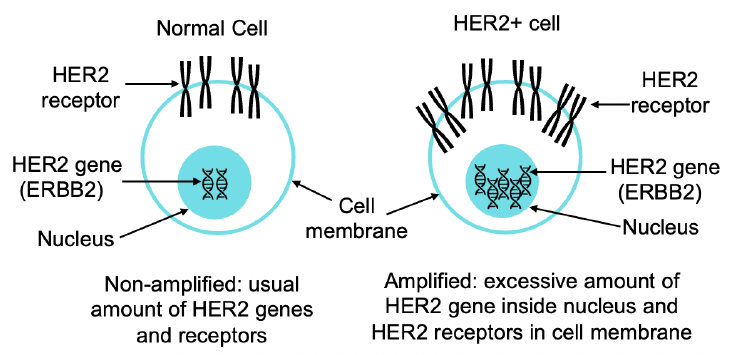
Figure 1. Example of normal and HER2 positive cell.